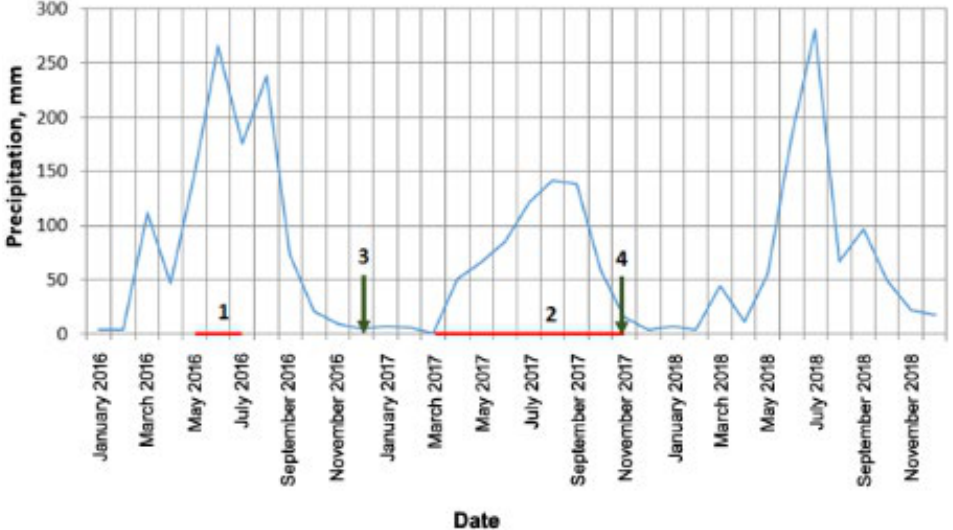
Figure 14. Annual precipitation level (in mm) according to Sektagli meteorological data. A connection between the intra-annual displacement rates and the level of precipita- tions is illustrated in Figure 15.